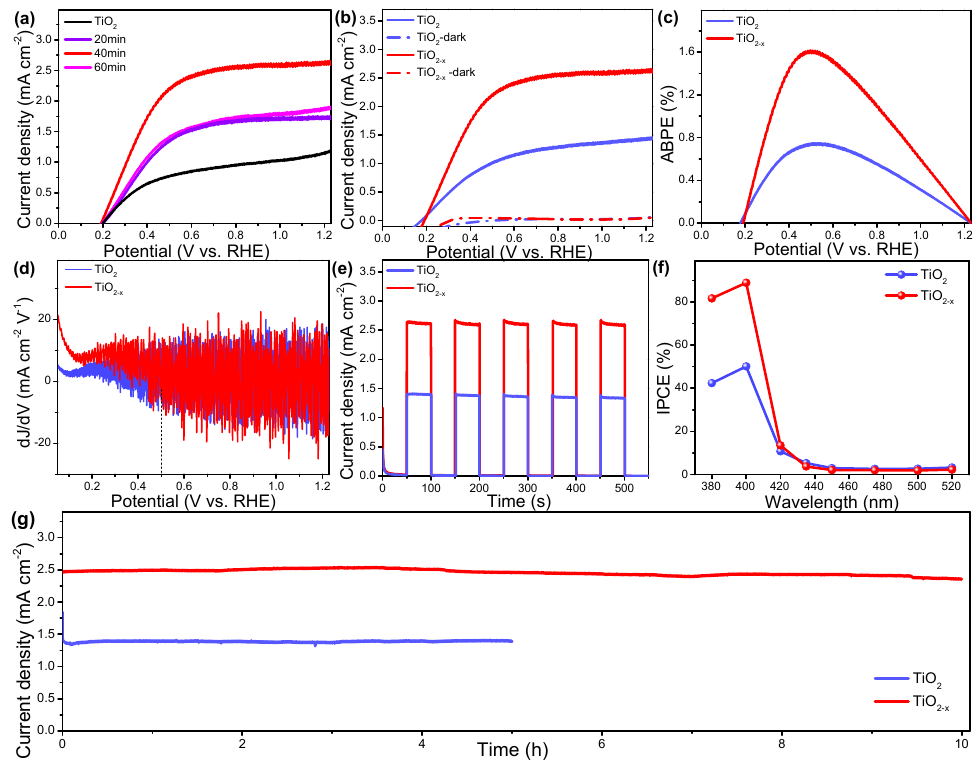
Figure 3. ( a ) LSV curves of TiO 2-x photoanodes with different NaBH 4 reduction times; ( b ) LSV curves; ( c ) ABPE values; ( d ) derivative curves of current with respect to voltage; ( e ) chopped current-time curves; ( f ) IPCE plots; ( g ) stability test at 1.23 V vs. RHE of TiO 2 and TiO 2-x photoanodes.